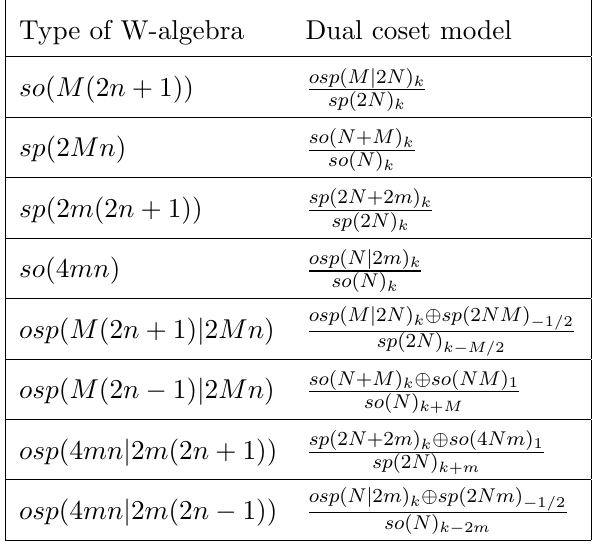
Table 3 . Alternative proposals on the coset models whose symmetries are realized by the rectan- gular